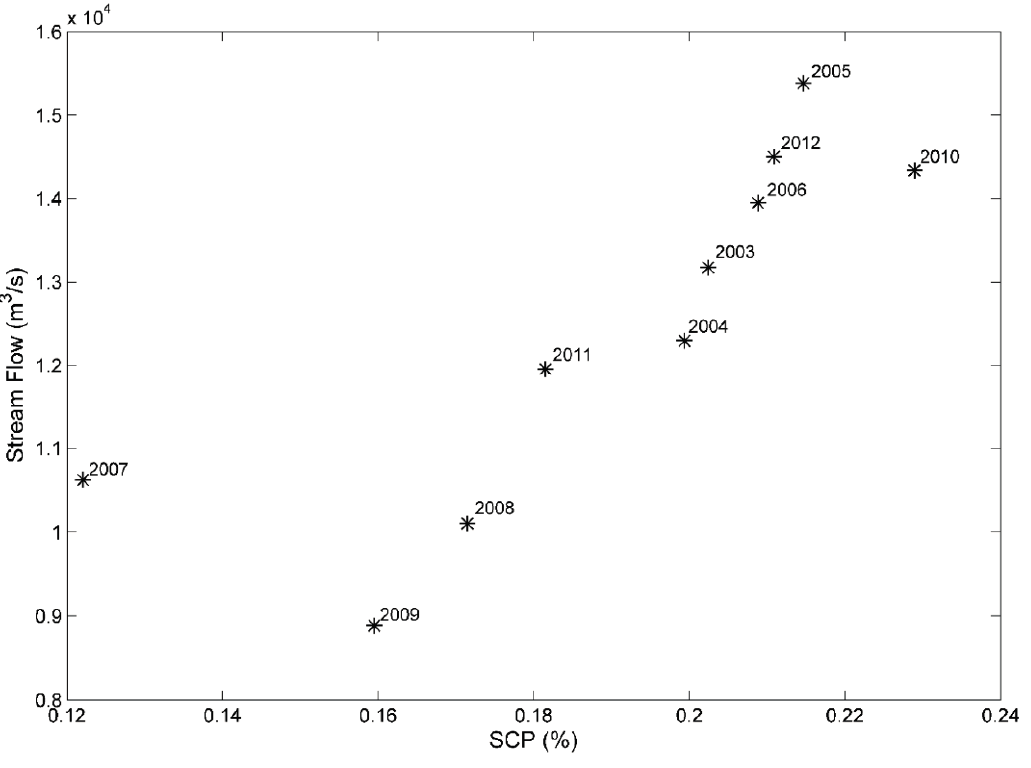
Figure 9. Annual mean SCPs and total stream flow in the 10 hydrological years in the Tizinafu